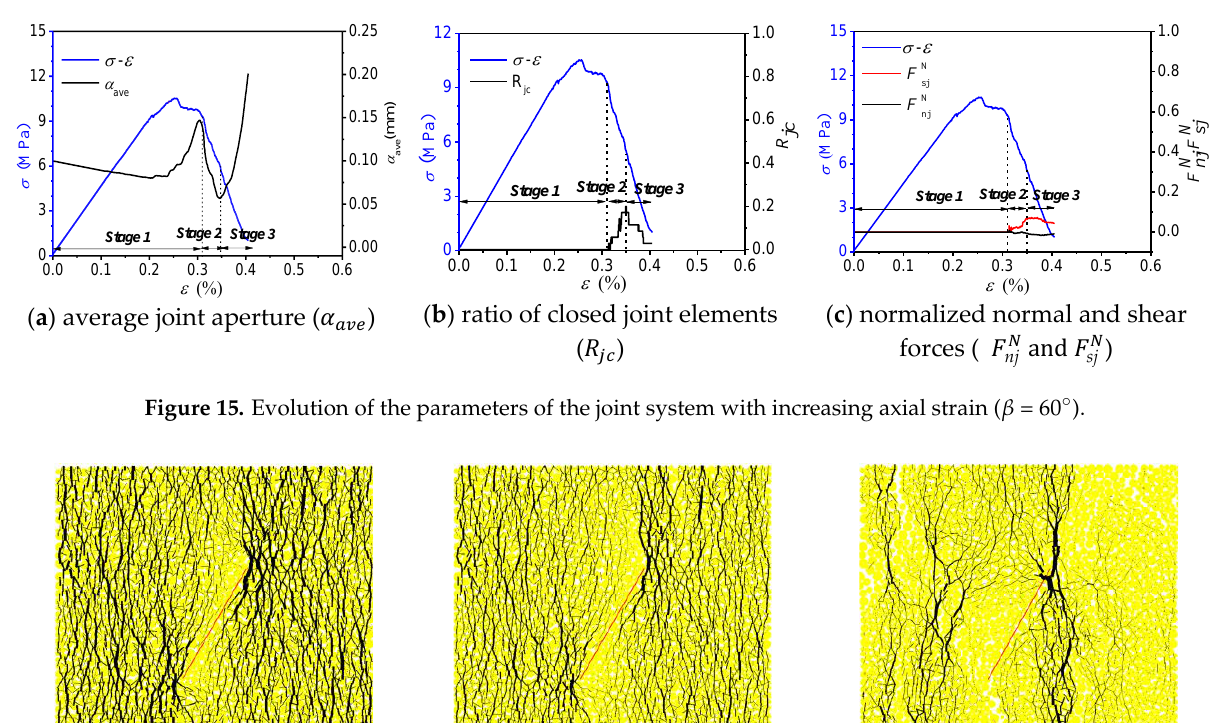
Figure 14. Evolution of force chain distribution with axial strain increases ( 𝛽 =45°).